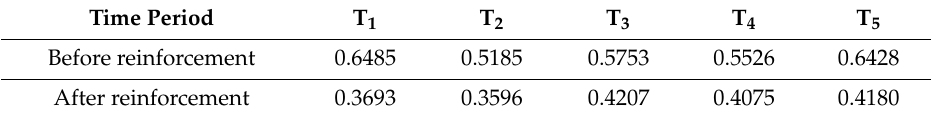
Table 13. The distance between the IVIFSs of first evaluation index and the ideal solution.